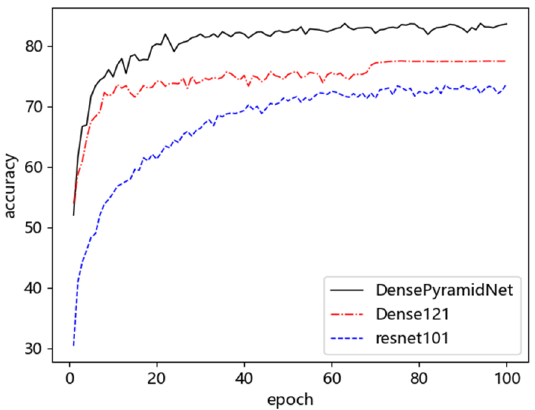
Figure 10. Test results of three algorithms on the cifar10.